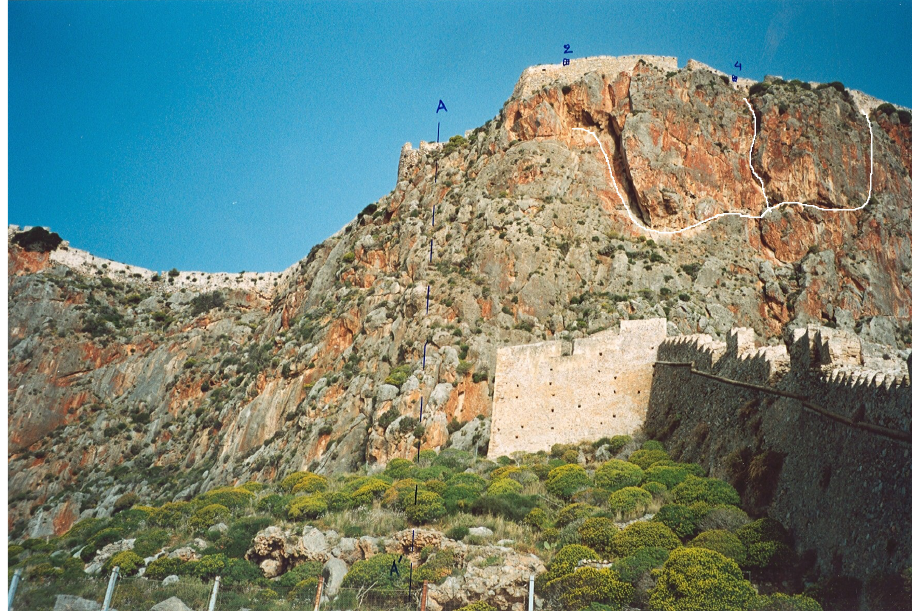
Fig. 10. Photo of a section of the slope having hanging blocks with very large dimensions.